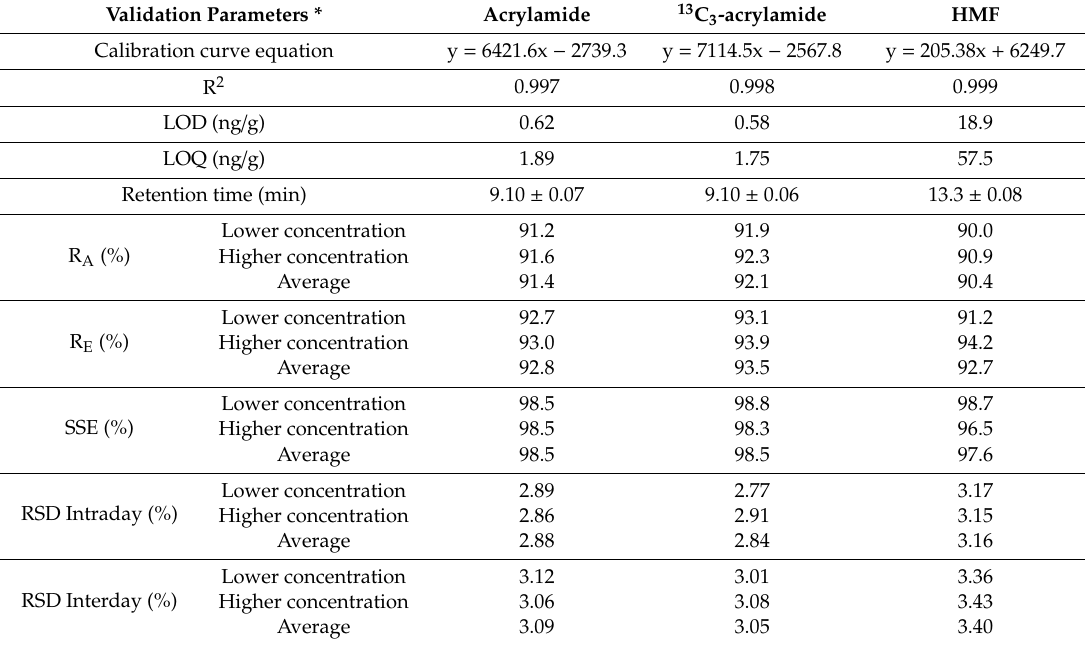
Table 1. Validation parameters of the used LC-MS / MS